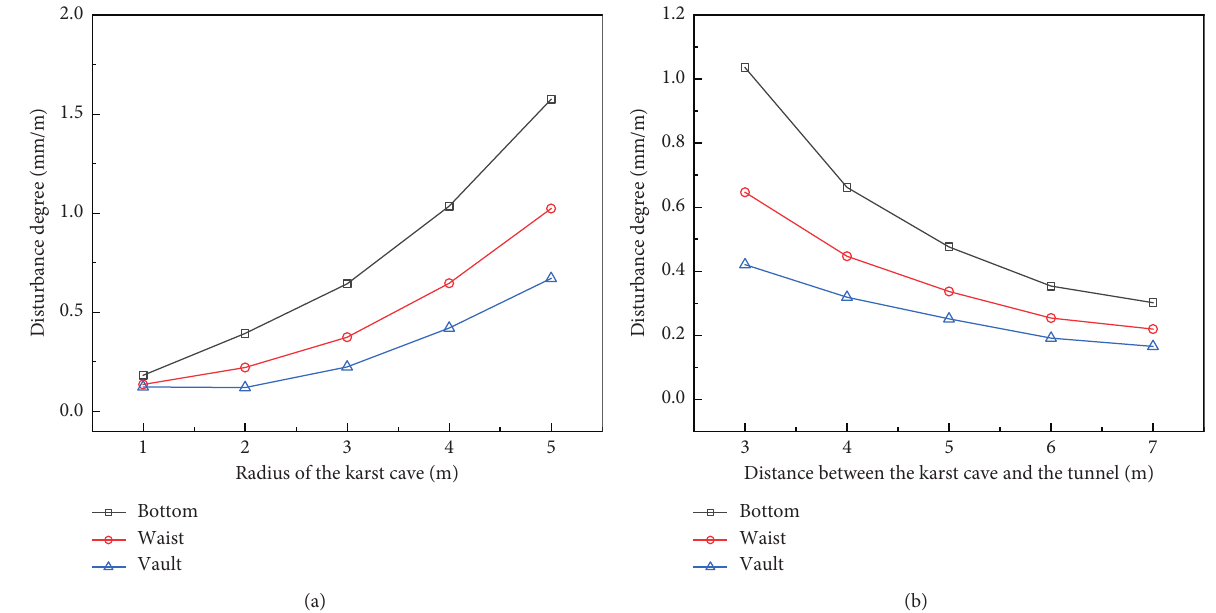
Figure 14: Change law of the disturbance degree with (a) varying sizes and (b) locations of the karst cave.